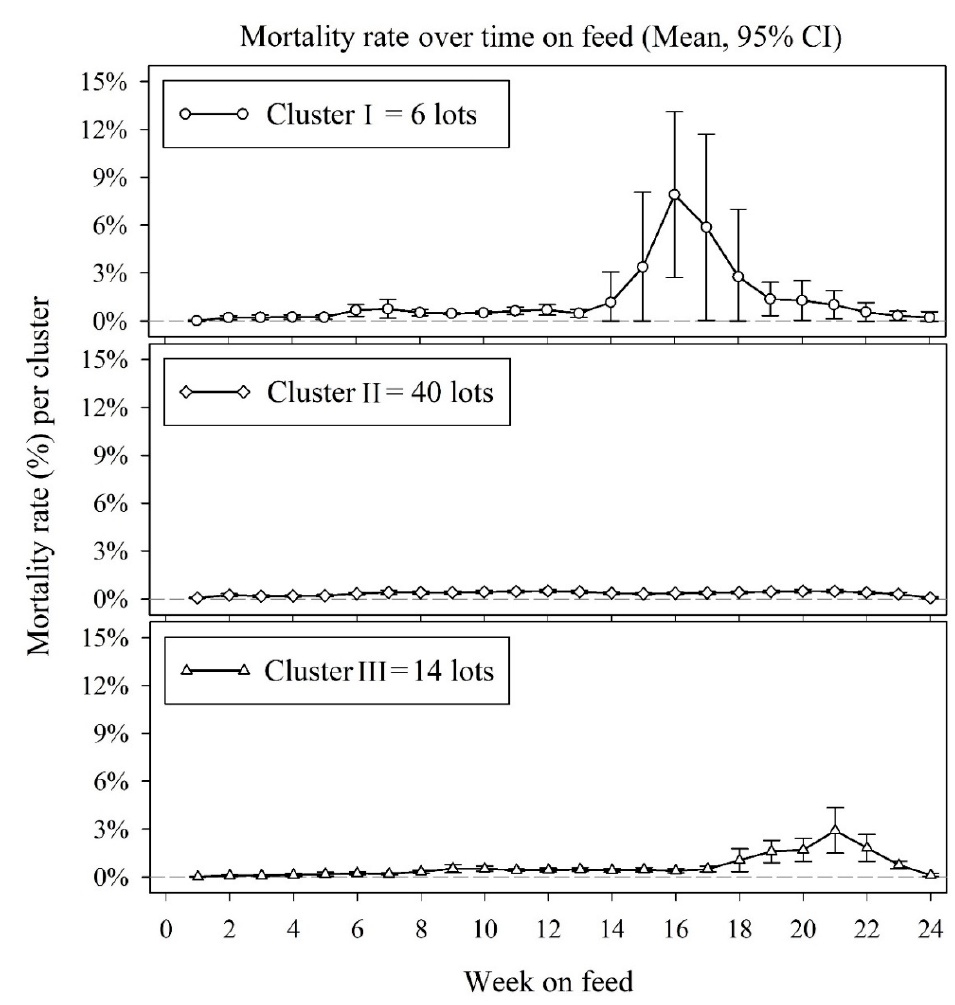
Figure 3. Cumulative mortality by week on feed. Clusters correspond to three mortality rate patterns: cluster I peak before week 17; cluster II constant low mortality over time; cluster III peak after week 17.